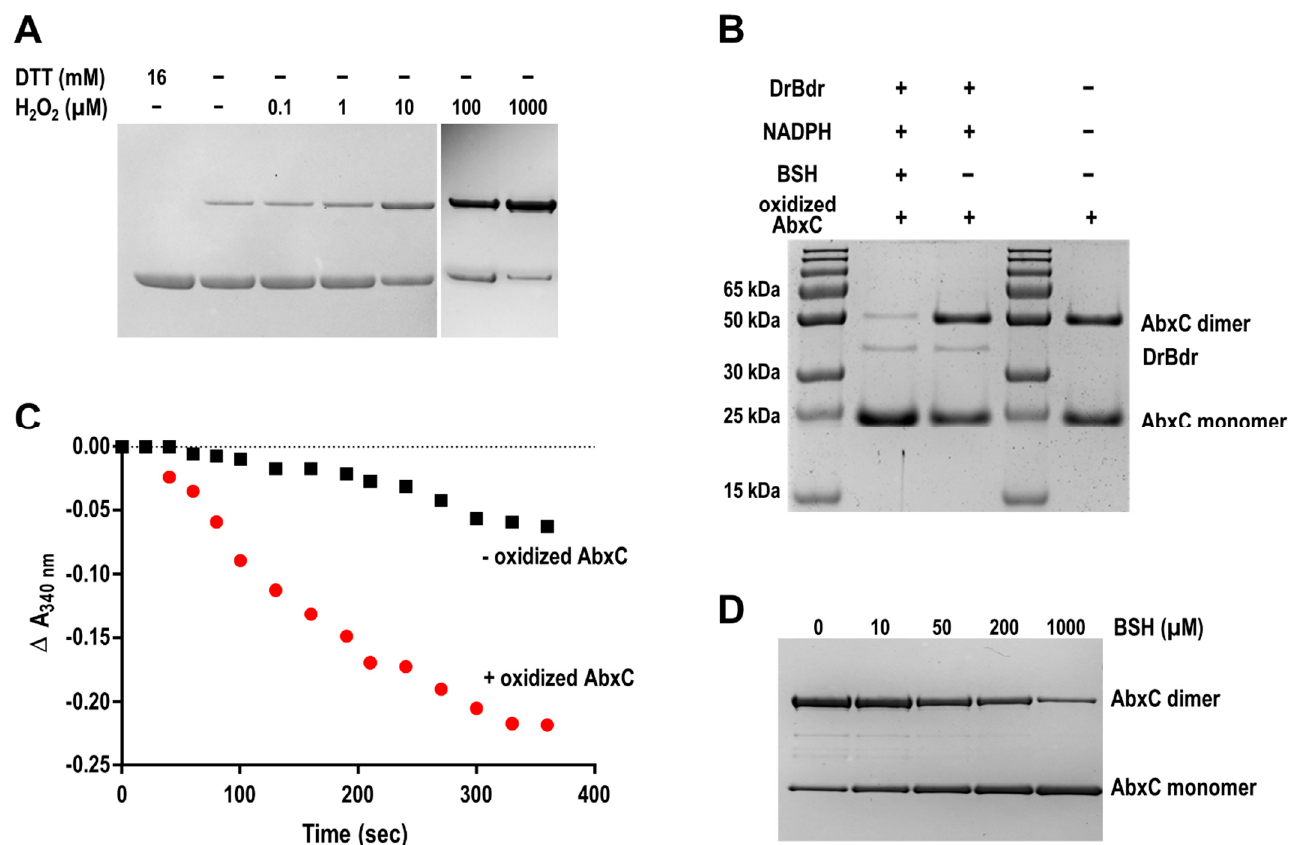
Figure 5. Dimer–monomer transition property of AbxC. ( A ) Effect of H 2 O 2 on AbxC oxidation. The purified AbxC proteins (0.5 mg/mL) were incubated with increasing concentrations of H 2 O 2 in PBS for 15 min and then separated using non- reducing SDS-PAGE (12% gels). DTT was used for AbxC reduction. ( B ) Effect of BSH in reduction of oxidized AbxC. AbxC proteins (0.5 mg/mL) oxidized by diamide treatment were incubated alone or with DrBdr (0.5 µ M)/NADPH (500 µ M)/BSH (500 µ M) for 15 min in 20 mM Tris-HCl pH 7.5 at room temperature. The samples were analyzed by non-reducing SDS/PAGE. Bands representing the AbxC monomers and dimers and DrBdr are indicated. ( C ) NADPH consumption by oxidized AbxC. The reaction mixtures contained 500 µ M BSH, 500 µ M NADPH, and 0.5 µ M DrBdr. Time-dependent consumption of NADPH was monitored at 340 nm immediately after addition of AbxC ( − oxidized AbxC) or oxidized AbxC (+ oxidized AbxC). The experiments were repeated twice and representative data are shown. ( D ) Effect of BSH on AbxC reduction. AbxC proteins (0.5 mg/mL) were oxidized by diamide treatment and incubated with the indicated concentrations of BSH for 15 min in 20 mM Tris-HCl containing 500 µ M NADPH. The mixtures were separated using non-reducing SDS-PAGE (12% gels).